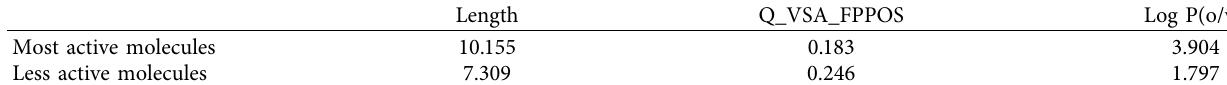
Table 10: Average values of